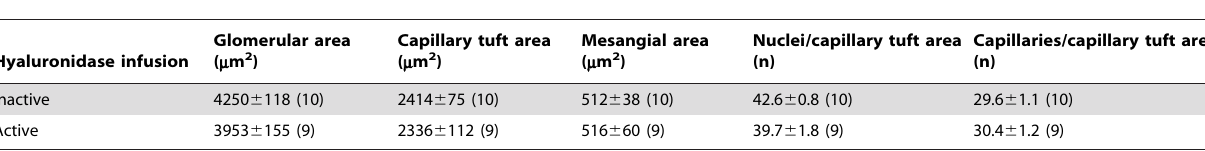
Table 2. Renal morphology in apoE 2 / 2 mice on HFC for 10 weeks with a final 4 week hyaluronidase